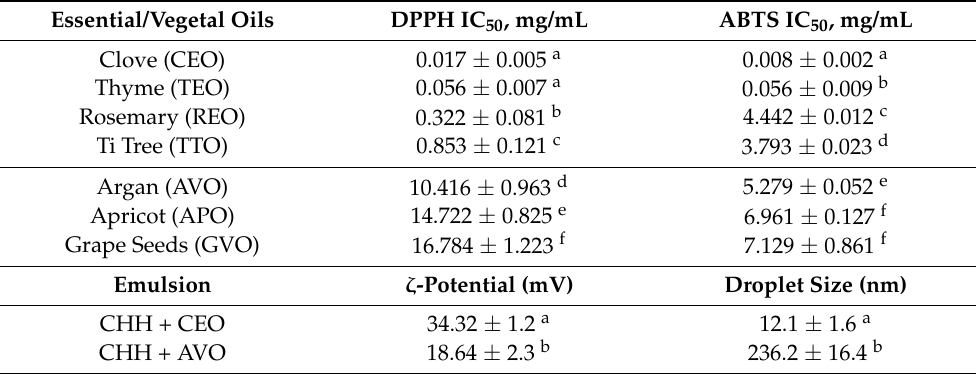
Table 1. The radical scavenging ability (IC50) of the selected essential and vegetal oils and character- istics of CEO and AVO chitosan emulsions. Essential/Vegetal